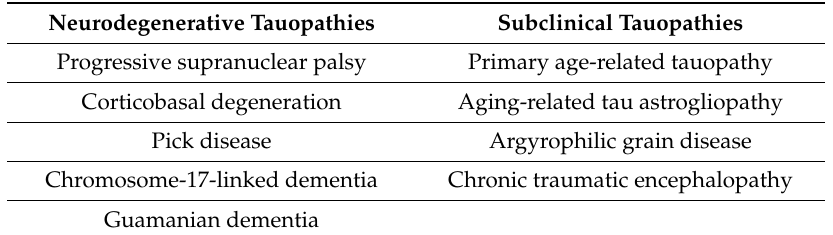
Table 1. Examples of neurodegenerative tauopathy and subclinical